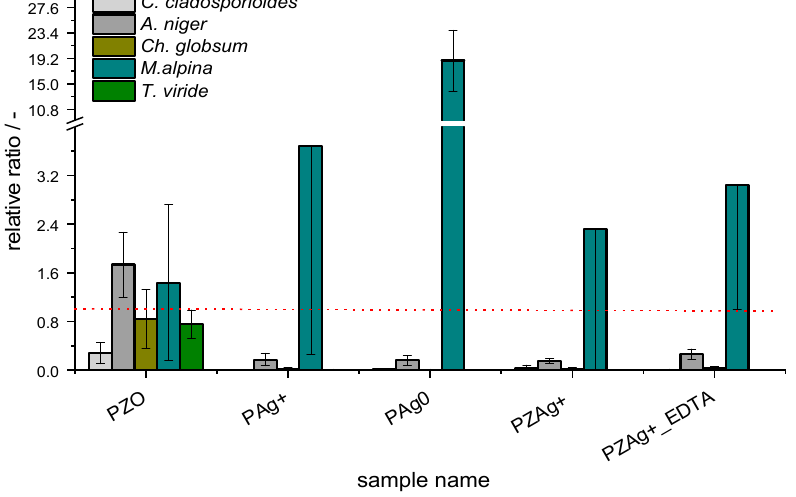
Figure 2. The relative ratio of adenosine phosphates as compared to control values (fungi).